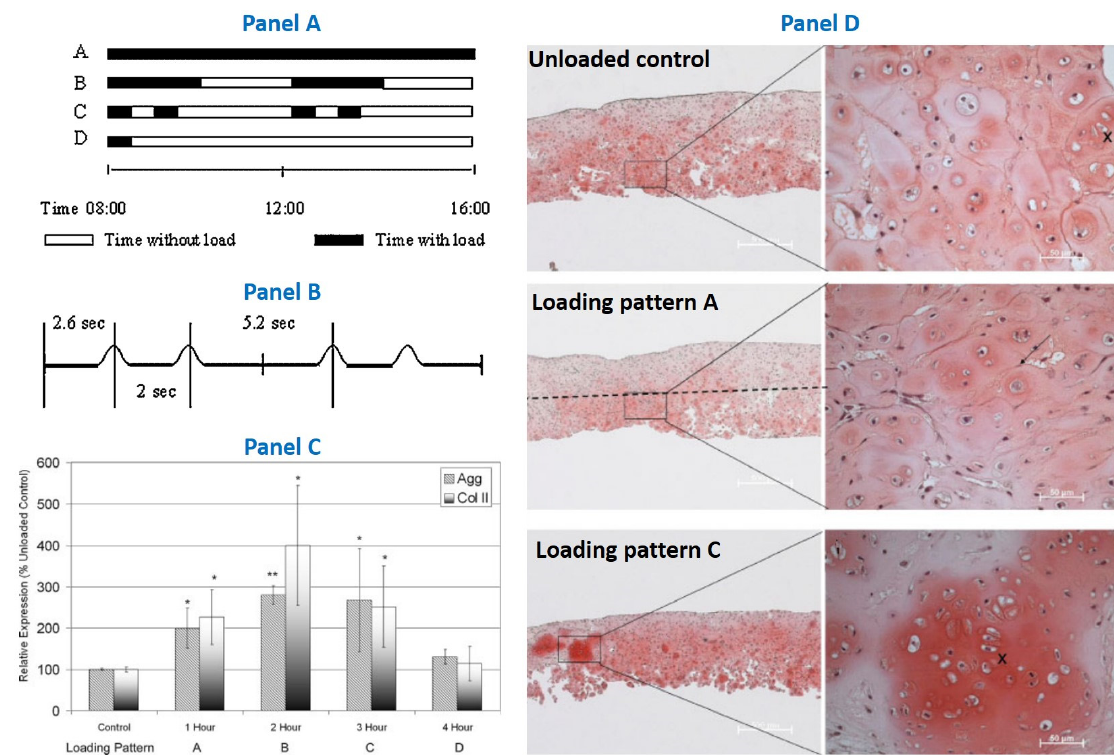
Figure 7. Dynamic load applied for 2 h each morning and afternoon (loading pattern B) enhance matrix synthesis and incorporation while dynamic load applied for 8 h a day (loading pattern A) appear to be detrimental for extra cellular matrix deposition. This finding may be of significant clinical relevance when planning rehabilitation of patients recovering from cartilage repair treatments which involve cell transfer or immature tissue. Schematic illustration of the loading patterns applied ( panel A ): cyclical loading for 8 h a day (loading pattern A); cyclical loading for 2 h in the morning and afternoon (loading pattern B); two times 30 min in the morning and afternoon (loading pattern C); cyclical loading for 30 min in the morning (loading pattern D). Timing of load within one loading cycle ( panel B ). Gene expression levels ( panel C ) of type II collagen (Col II) and aggrecan (Agg) (* p < 0.05, ** p < 0.01). Safranin O staining ( panel D ) after 4 days of unloaded control, cyclical loading for 8 h a day (loading pattern A) and two times 30 min in the morning and afternoon (loading pattern C) Arrows highlight the PCM border developed when the cells were grown in alginate beads. Loading pattern C lead to more fused matrix (x) showing more integration between the individual chondrons. Images modified with permission from M.J. Stoddart at al., 2006 [290].